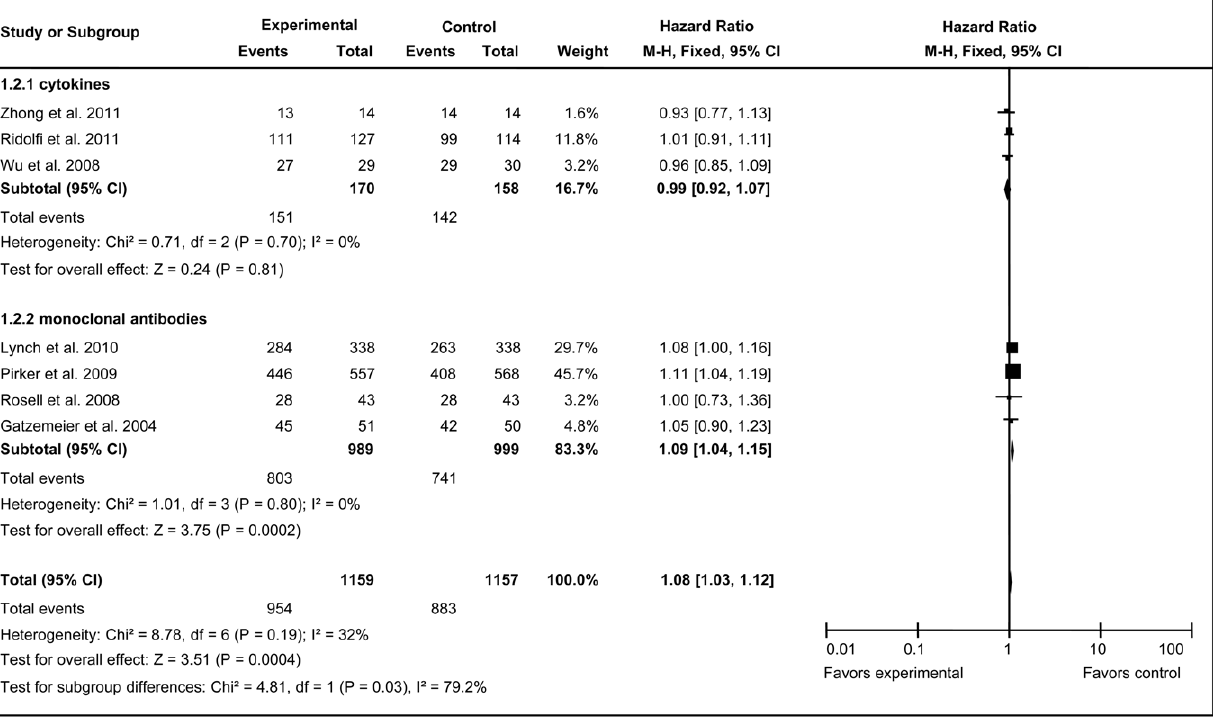
Figure 3. Forest plot of comparison of progression-free survival of 7 included studies (Stage IIIA, IIIB, or IV NSCLC). P values are from P-for-effect modification testing for heterogeneity within or across the groups of regimens. The sizes of data markers are proportional to the number of PFS events in the trials. CI, confidence interval; HR, hazard ratio.